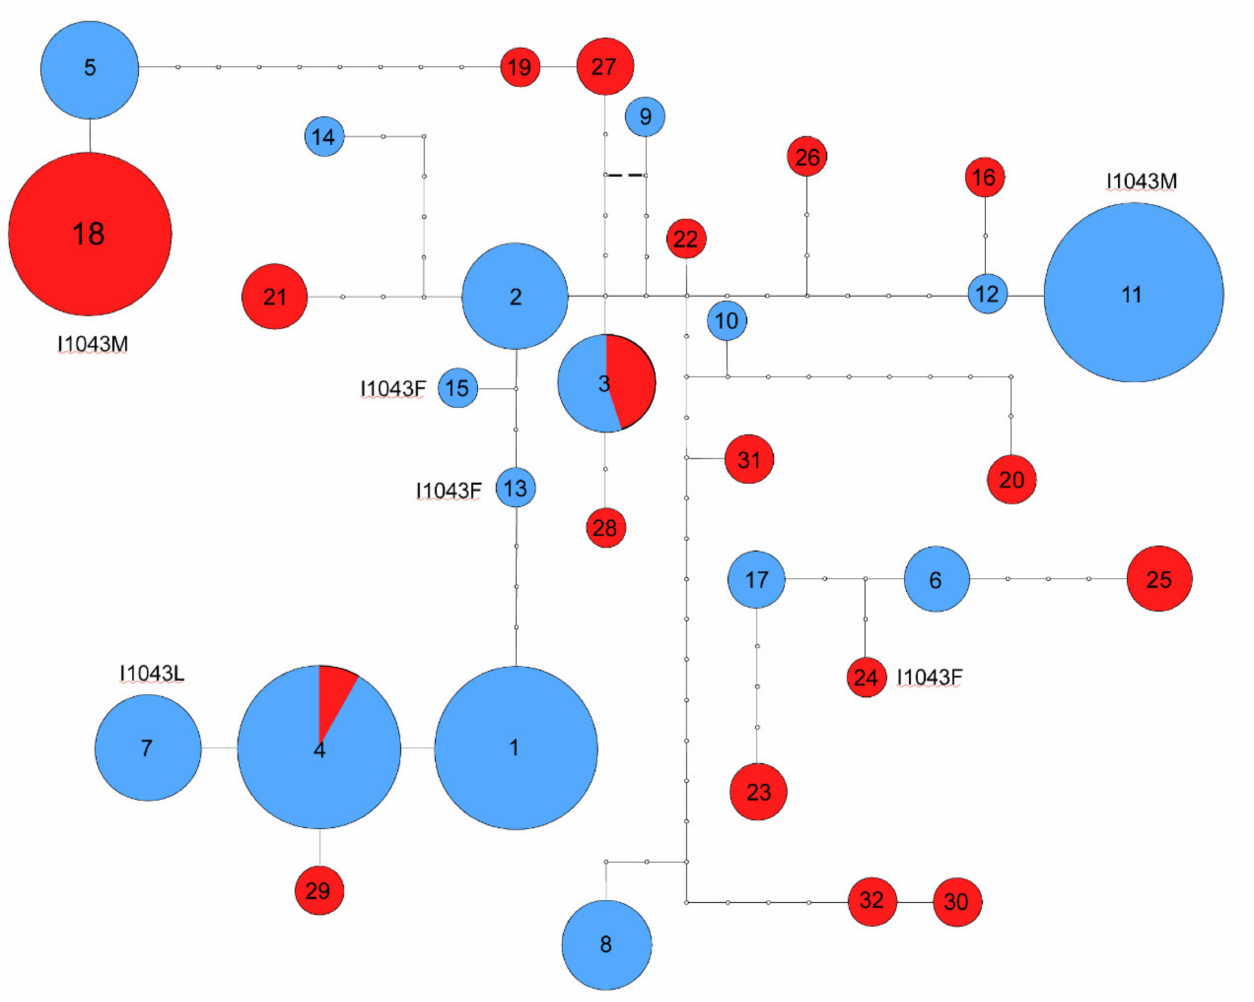
Figure 2. Statistical parsimony network showing the phylogenetic relationships among the 32 chs-alleles observed in the Culex pipiens populations. Alleles are shown as circles with sizes corresponding to their frequencies in the total sample. Alleles are encoded as in Table 1. Open dots are missing intermediate haplotypes. For each resistant allele, the name of the mutation is